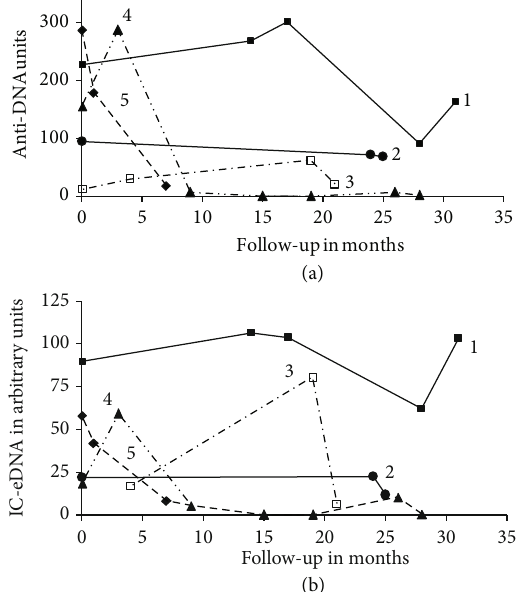
Figure 6: Variation of the anti-DNA antibody levels in the top fi gure and circulating DNA immune complexes (IC-eDNA) in the bottom fi gure detected by FCM during patient follow-up. Five representative patients (1-5) are shown. All patients had a medical treatment. In FCM, one arbitrary unit for IC-eDNA was de fi ned as equivalent to the number of events observed with one unit of anti-DNA antibodies incubated with calf thymus DNA, in the gate built around DNA immune